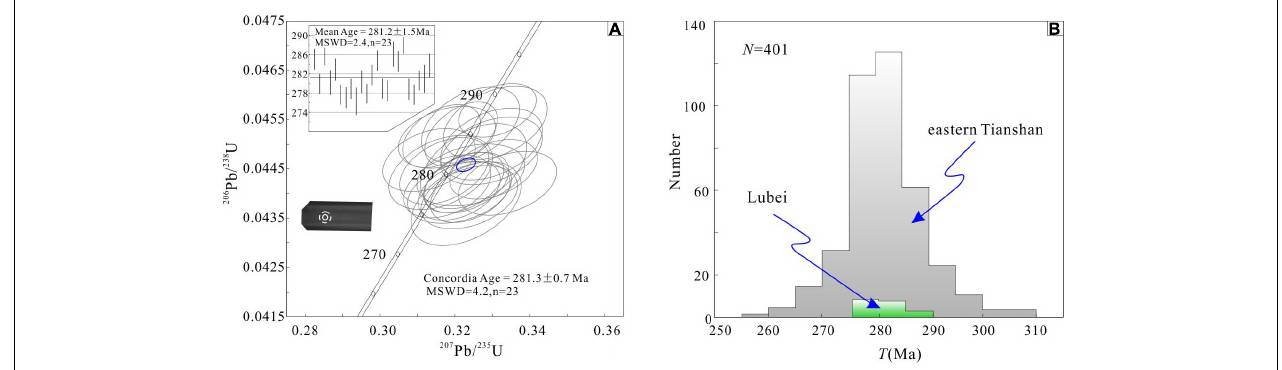
FIGURE 5 | Diagram of diagenetic age of Lubei diorite (A) and histogram of metallogenic age from Ni-Cu sulfide deposit in eastern Tianshan (B) . The data of eastern Tianshan from Supplementary Appendix 1